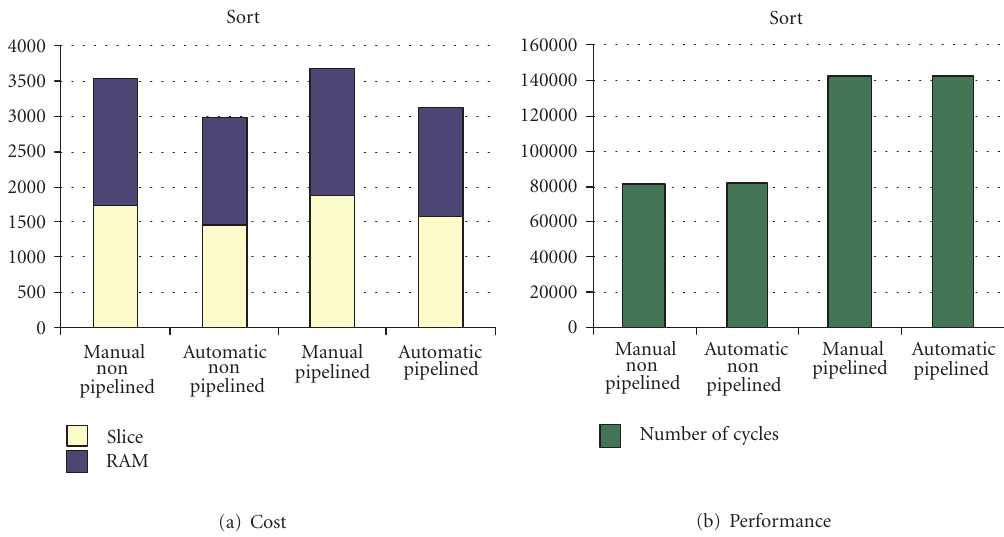
Figure 16: Sort: number of slices, number of RAMs, and number of cycles for manually selected and automatically generated data